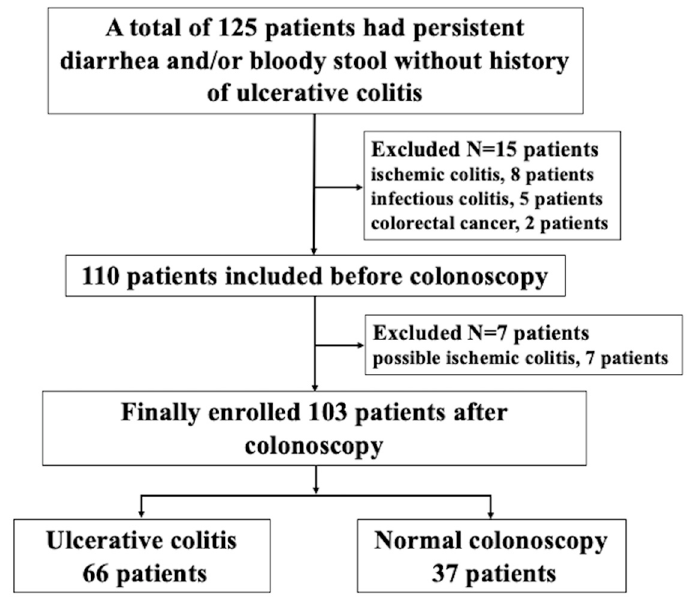
Figure 1. The flowchart of enrolled patients.